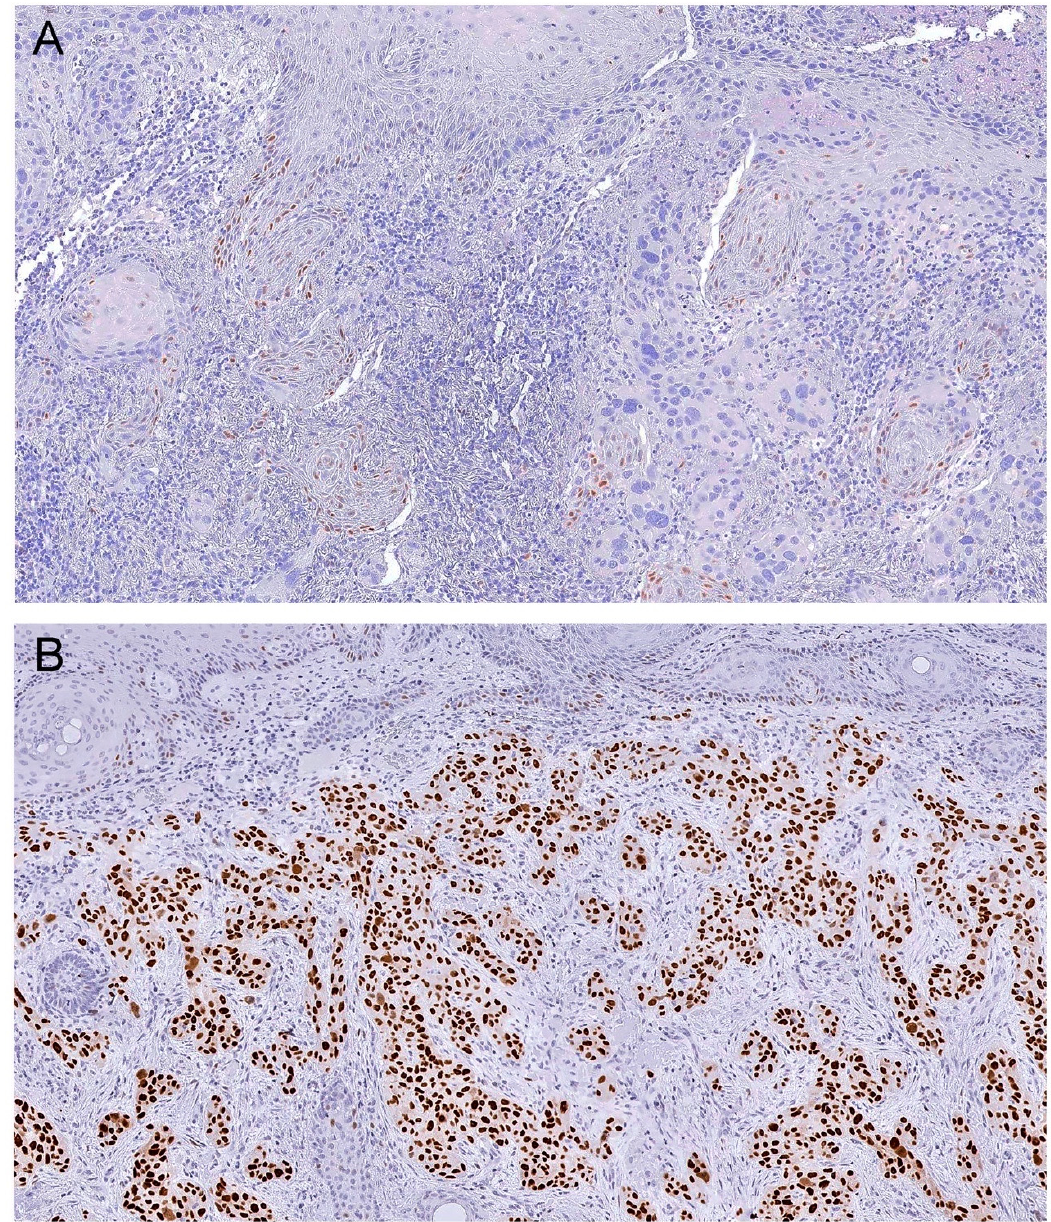
Figure 1. Representative images of immunoexpression of p53 in cutaneous squamous cell carcinomas (cSCCs) for ( A ) wild type expression and ( B ) overexpression. Original magnification 100×.